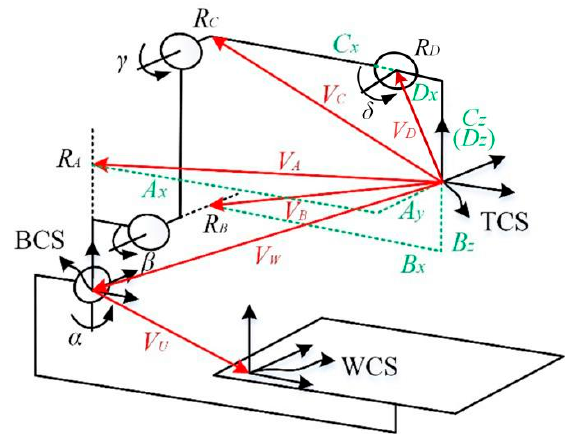
Figure 2. The kinematic chain of the multijoint industrial robot.